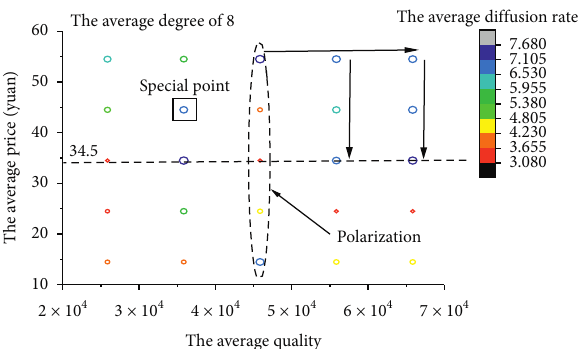
Figure 12: Influence of average quality and price on the mean diffusion rate with an average degree of